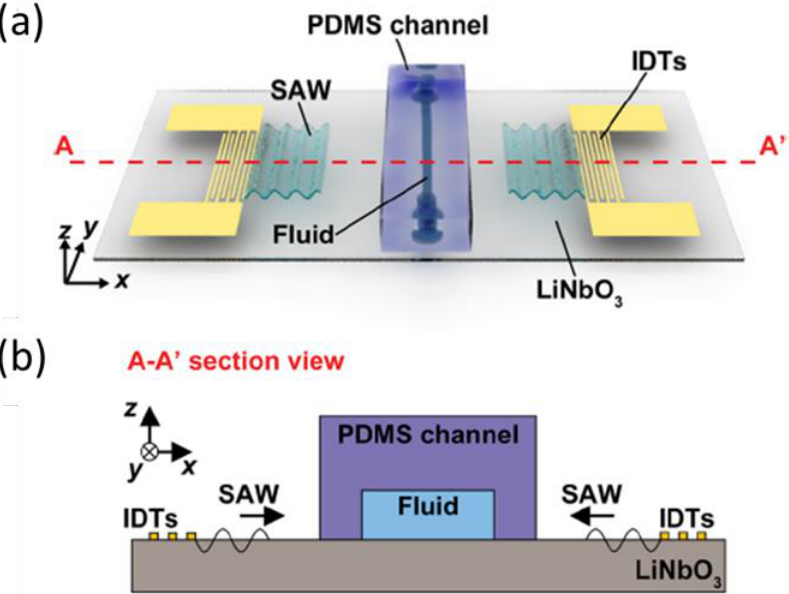
Figure 4. ( a ) Schematic of a general surface acoustic wave (SAW)-based acoustophoretic device composed of lithium niobate (LiNbO 3 ) substrate, interdigital transducers (IDTs), and a polydimethylsiloxane (PDMS) microchannel. ( b ) Cross-sectional view of the device [72]. When a surface standing acoustic wave (SSAW) is applied between the opposite walls of the channel (which act as reflectors) by exciting the piezoelectric elements, a harmonic standing pressure field is formed in the fluid. In most cases, a half-wavelength standing wave is usually generated in the lateral direction of the fluid channel (i.e., perpendicular to the continuous flow direction) with a pressure node in the channel center and pressure antinodes located at the channel walls [24]. Besides SSAW techniques, there